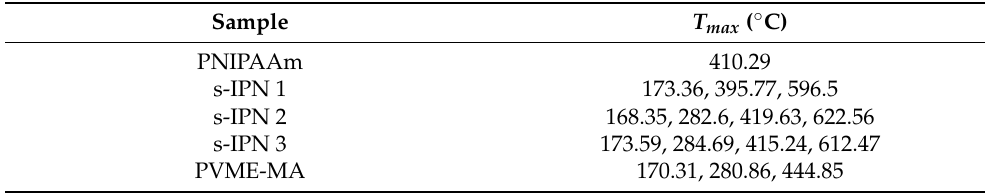
Table 3. T max for PNIPAAm hydrogel, PMVE-MA, and s-IPN samples.